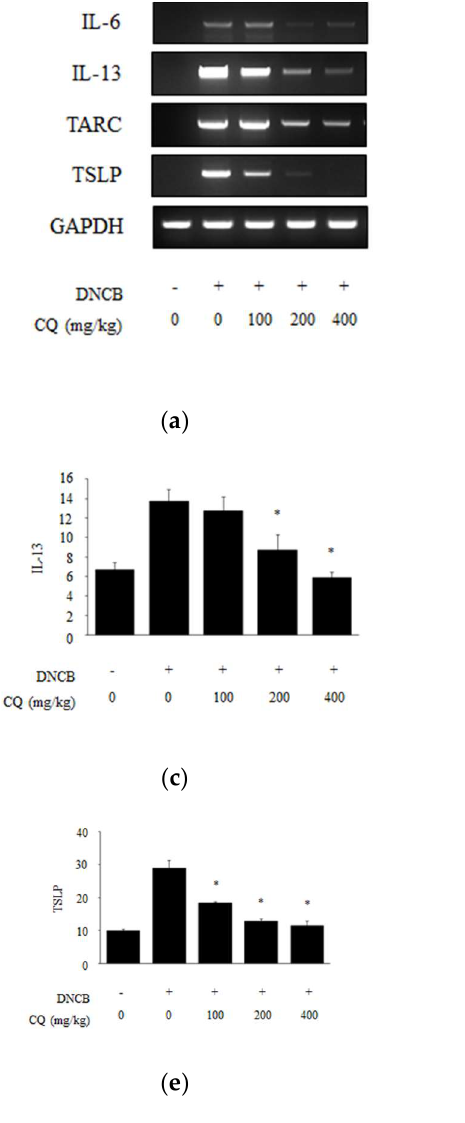
Figure 7. Proinflammatory cytokines and chemokines in DNCB-induced BALB/c mice. ( a ) To demonstrate the effect of CQ in DNCB-induced BALB/c mice, the tissue was collected and homogenized and the total RNA was extracted at the end of the experiment; ( b – e ) The expression of IL-6, IL-13, thymus and activation-regulated chemokine (TARC), and thymic stromal lymphopoietin (TSLP) was measured by reverse transcription polymerase chain reaction (RT-PCR) and densitometry protocol. All data are presented as mean ± SD; * p < 0.05 vs. DNCB-induced group.